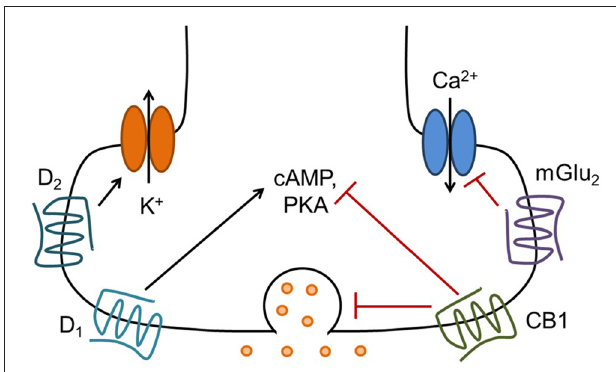
FIGURE 1 | Presynaptic G protein-coupled receptors (GPCRs) modulate neurotransmitter release via several mechanisms. Presynaptic G i/o -coupled GPCRs such as mGlu 2 , cannabinoid type 1 (CB1) and D 2 can reduce the probability of neurotransmitter release by inhibiting calcium influx through voltage-gated calcium channels, by directly modulating the function of vesicle release machinery, and possibly by activating inwardly rectifying potassium channels to hyperpolarize or shunt the presynaptic terminal. These receptors also reduce cyclic adenosine monophosphate (cAMP) levels and protein kinase A (PKA) activity via inhibition of adenylyl cyclase, which may contribute to long-term regulation of neurotransmitter release. Conversely, presynaptic D 1 receptors, which are coupled to G s /G olf and activate PKA signaling, can increase neurotransmitter release. There are likely many other mechanisms involved in the regulation of neurotransmitter release by GPCRs, including activation of other signaling pathways and stimulation of protein synthesis (see Atwood et al., 2014b for further